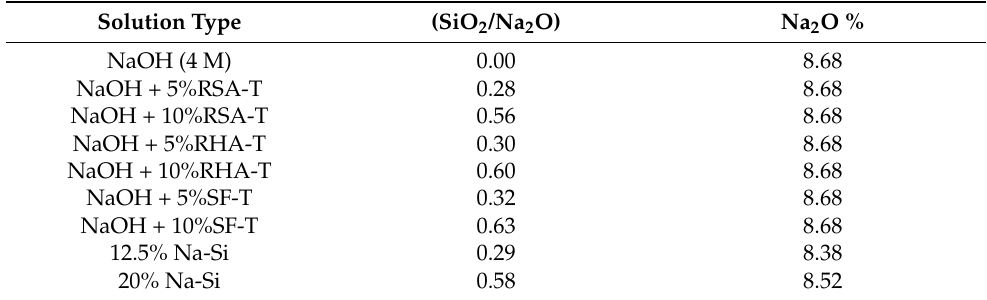
Table 2. Modulus ratios (SiO 2 /Na 2 O) and sodium oxide content of activator solutions.